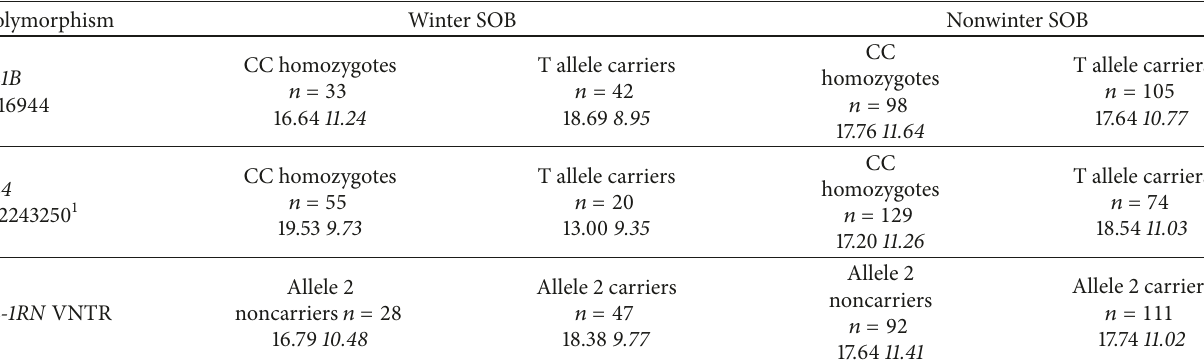
Table 3: Means and SD of the SPQ total score by SOB and